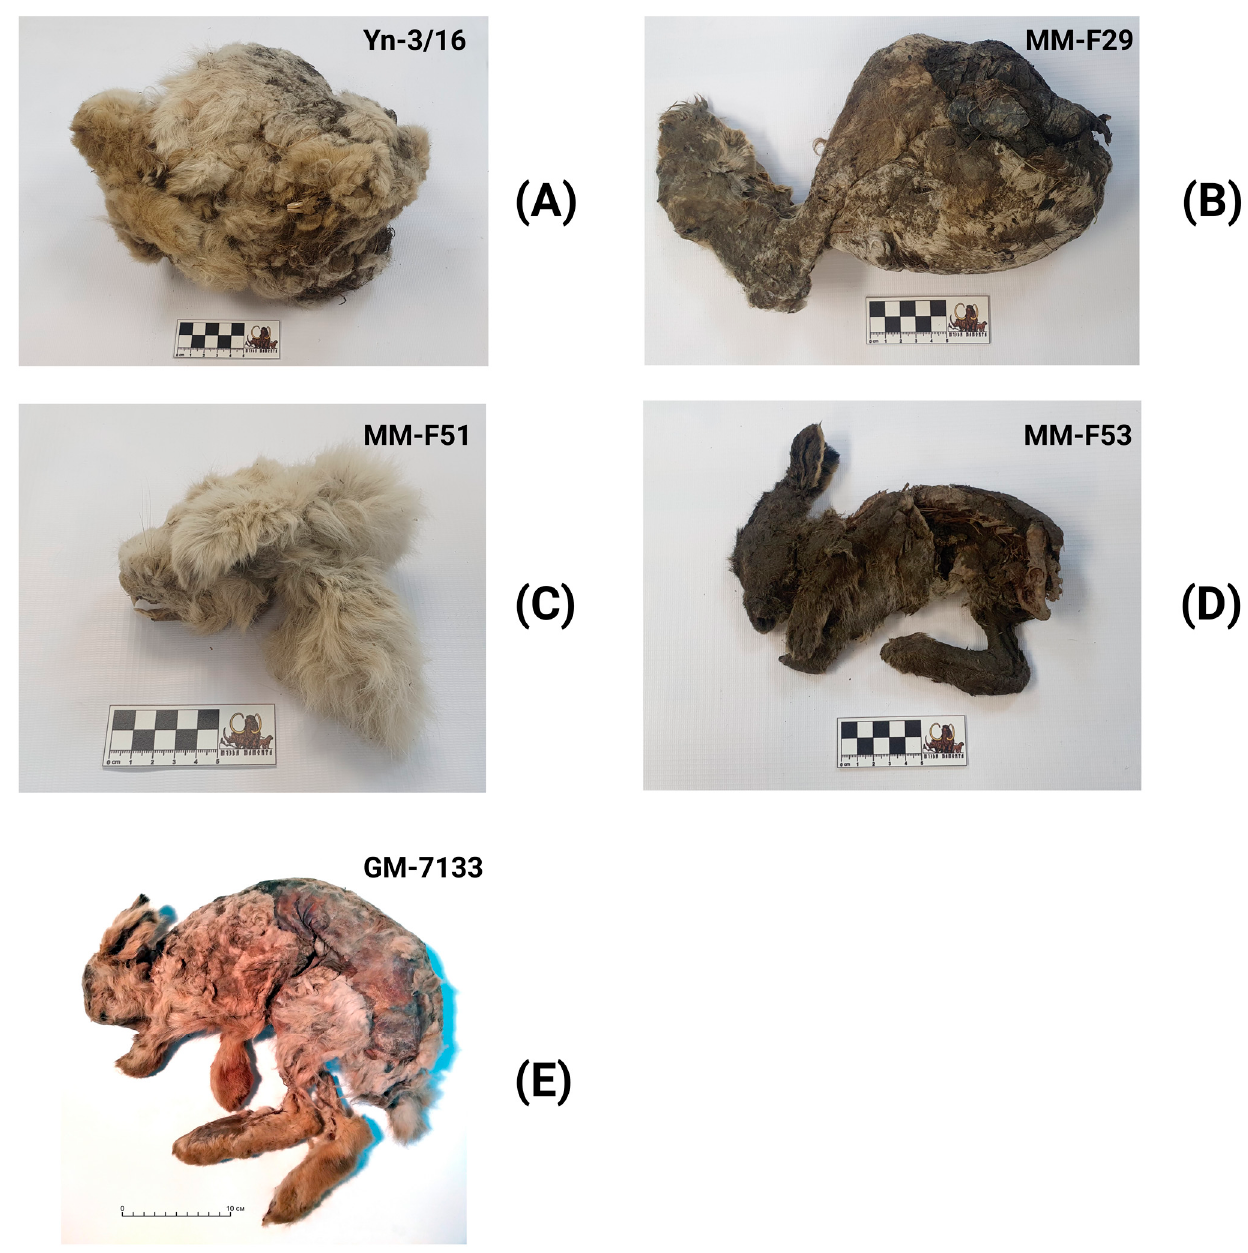
Figure 2. Frozen mummies of Don-hare used in this study. The Don-hare specimen description is presented in Table 1. ( A ) Specimen Z1 (Yn-3/16); ( B ) Specimen Z3 (MM-F29); ( C ) Specimen Z4 (MM-F51); ( D ) Specimen Z5 (MM-F53); ( E ) Z43 (GM-7133). Three specimens (Yn-3/16, MM-F29, and MM-F51) were radiocarbon dated at the Carbon Analysis Lab Co., Ltd. (Gyeryong, Republic of Korea), and one specimen (MM- F53) at the Unique Scientific Facility «AMS BINP SB RAS» (Novosibirsk, Russia) was dated based on acid-based collagen extracted fraction. The acid–alkali–acid method